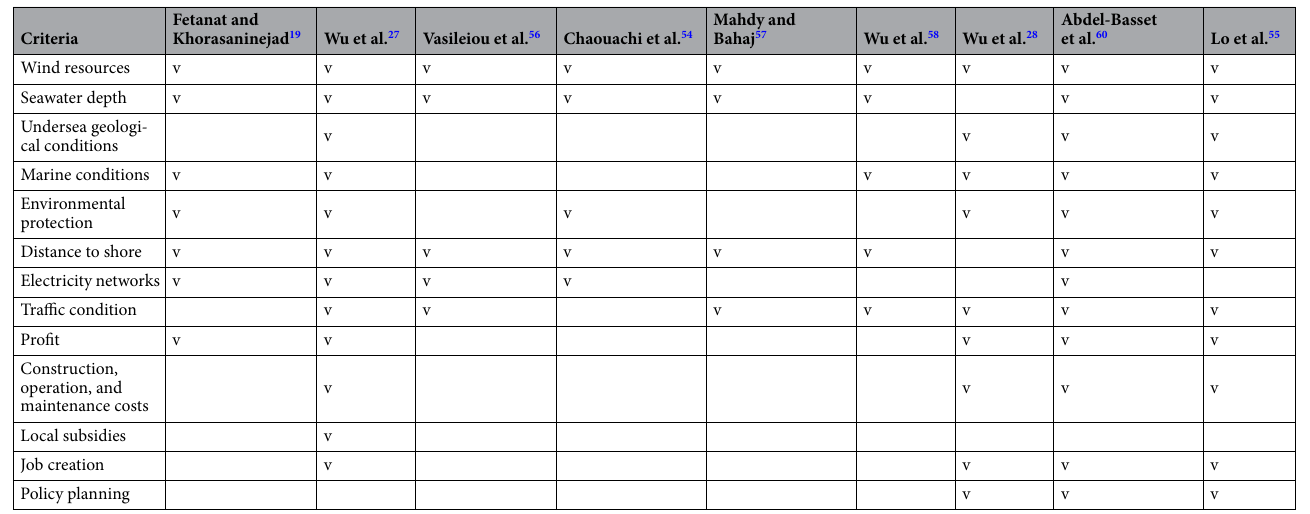
Table 2. Summary of criteria considered from the literature